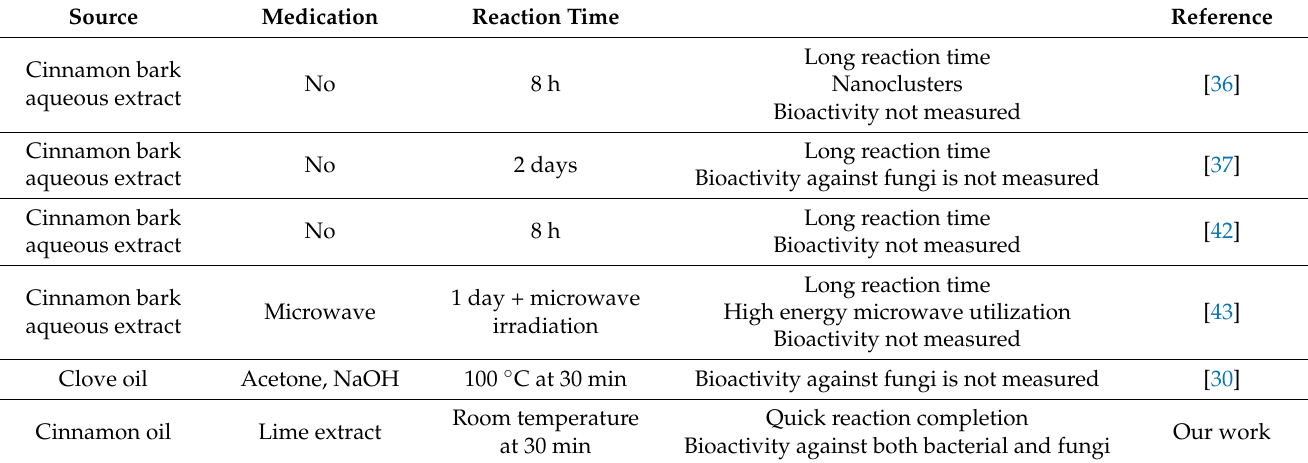
Table 2. Comparison of current research work with other related